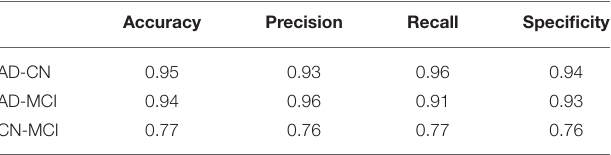
TABLE 2 | Predictive performance of the SVM classifier. Accuracy Precision Recall Specificity